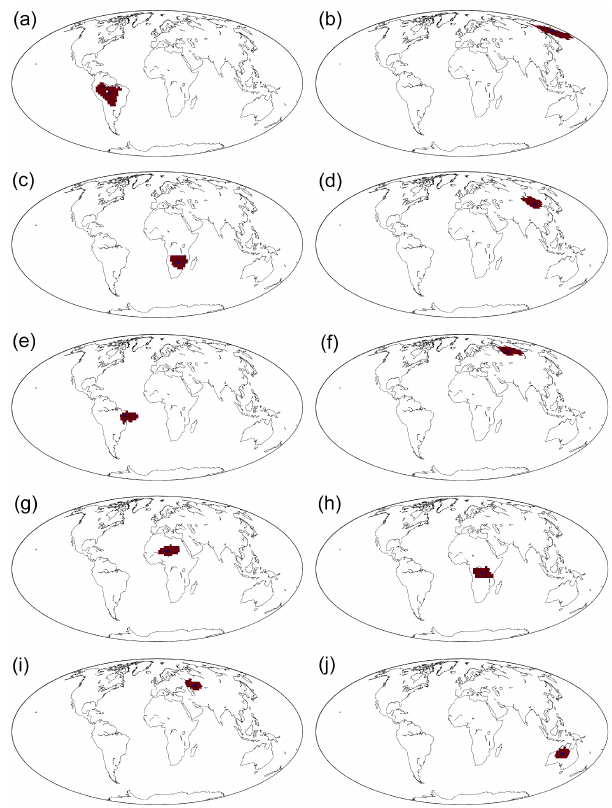
Figure 10. Footprints for the top 10 grid boxes from distinct ter- restrial areas that will provide the greatest increase in the global coverage of ozone.